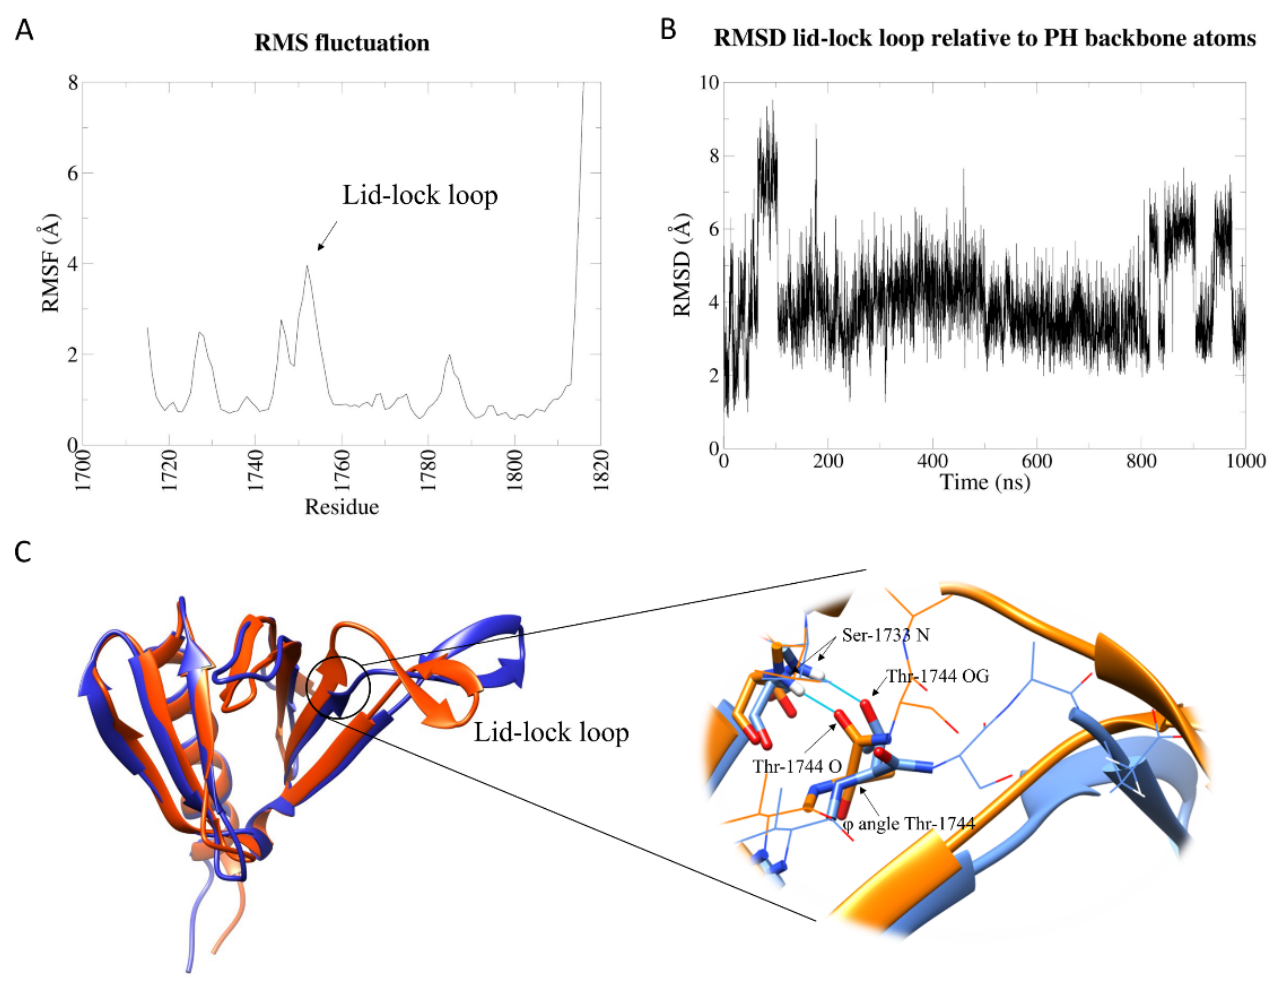
Figure 1. Analysis of the wt isolated PH domain MD simulation. ( A ) Root-mean-square fluctuation (RMSF) of backbone atoms of the PH domain. ( B ) Root-mean-square deviation (RMSD) of the backbone atoms of the lid-lock loop after superposition of the entire PH domain backbone atoms. ( C ) On the left, cluster 1 (orange) and cluster 2 (blue) centroids structures were superimposed. The two structures differ by a conformational change at the N-terminal part of the lid-lock loop, resulting in a left–right swing of the loop; on the right, zoom on the structural differences between cluster 1 and cluster 2 structures. The φ angle of T144 is rotated in cluster 2 structure, resulting in changing the direction of the loop. The carbonyl oxygen of T1744 is substituted by the hydroxyl oxygen (OG) of T1744 sidechain in the H-bond with S1733.